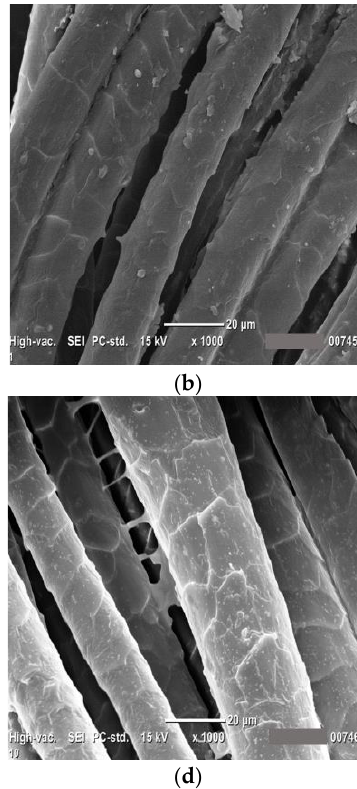
Figure 16. SEM photos of PUPXC6PW-treated samples after zero washing cycles ( a ), one washing cycle ( b ), five washing cycles ( c ), and ten washing cycles ( d ).